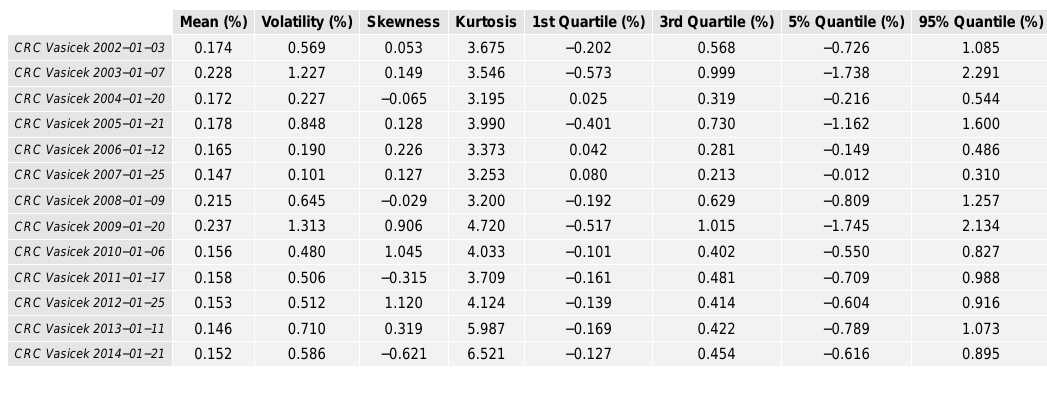
Table 2. Statistics computed from the simulations of the test portfolio returns for some of the monthly periods in the consistent re-calibration (CRC) counterpart of the Vasiˇcek model with stochastic volatility. For each monthly period, we simulate 10 4 realizations.